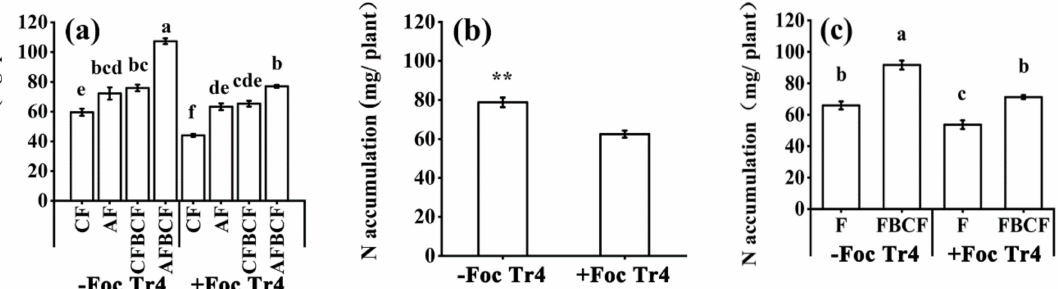
Figure 5. Effects of alkaline fertilizer and biocontrol fungi on N accumulation of banana 60 days after Foc Tr4 inoculation. ( a ) Effect of each treatment on N accumulation. ( b ) Effect of inoculation of pathogen (main plots) on N accumulation. ( c ) Effect of biocontrol fungi (sub-plots) on N accumulation. Different letters on pot of the bars indicated significant difference ( p < 0.05) among the